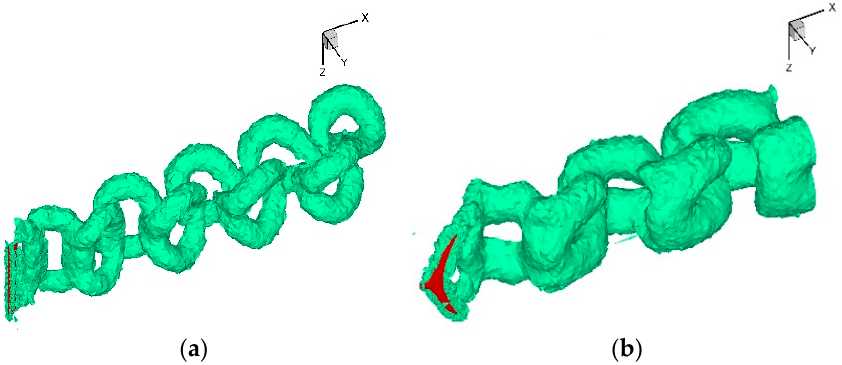
Figure 11. Three-dimensional vortex patterns in the wake: ( a ) NACA foil; ( b ) crescent-shaped foil.